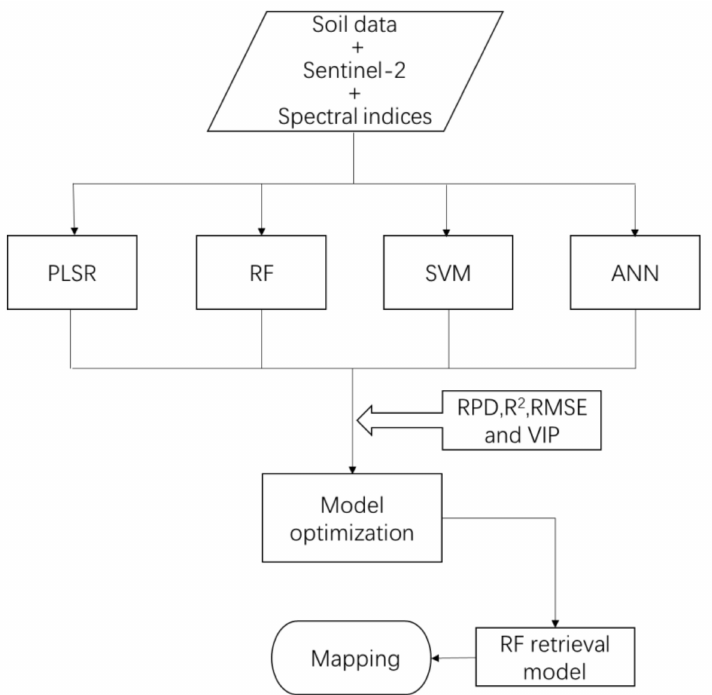
Figure 2. Flowchart showing the soil organic carbon (SOC) prediction method. PLSR = partial least squares regression; RF = random forest; SVM = support vector machine; ANN = artificial neural network; RPD = relative percent difference; R 2 = coefficient of determination; RMSE = root mean square error; VIP = variance importance in